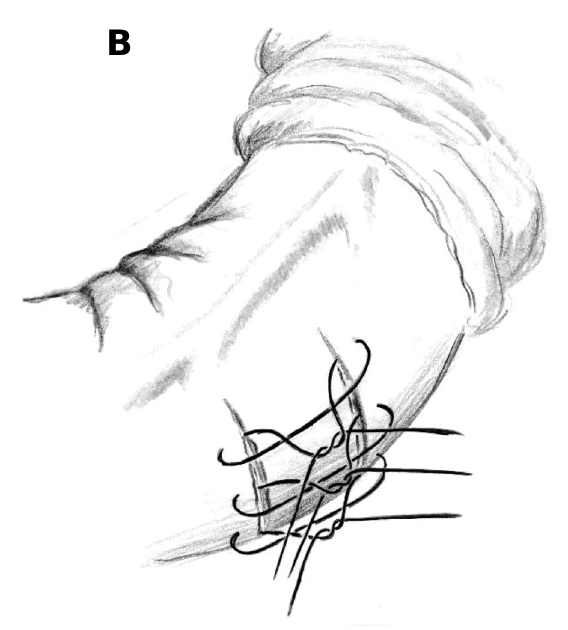
Figure - 1 , A and B - Slightly modified technique of the original Essed plication procedure with 2 parallel horizontal incisions into the tunica